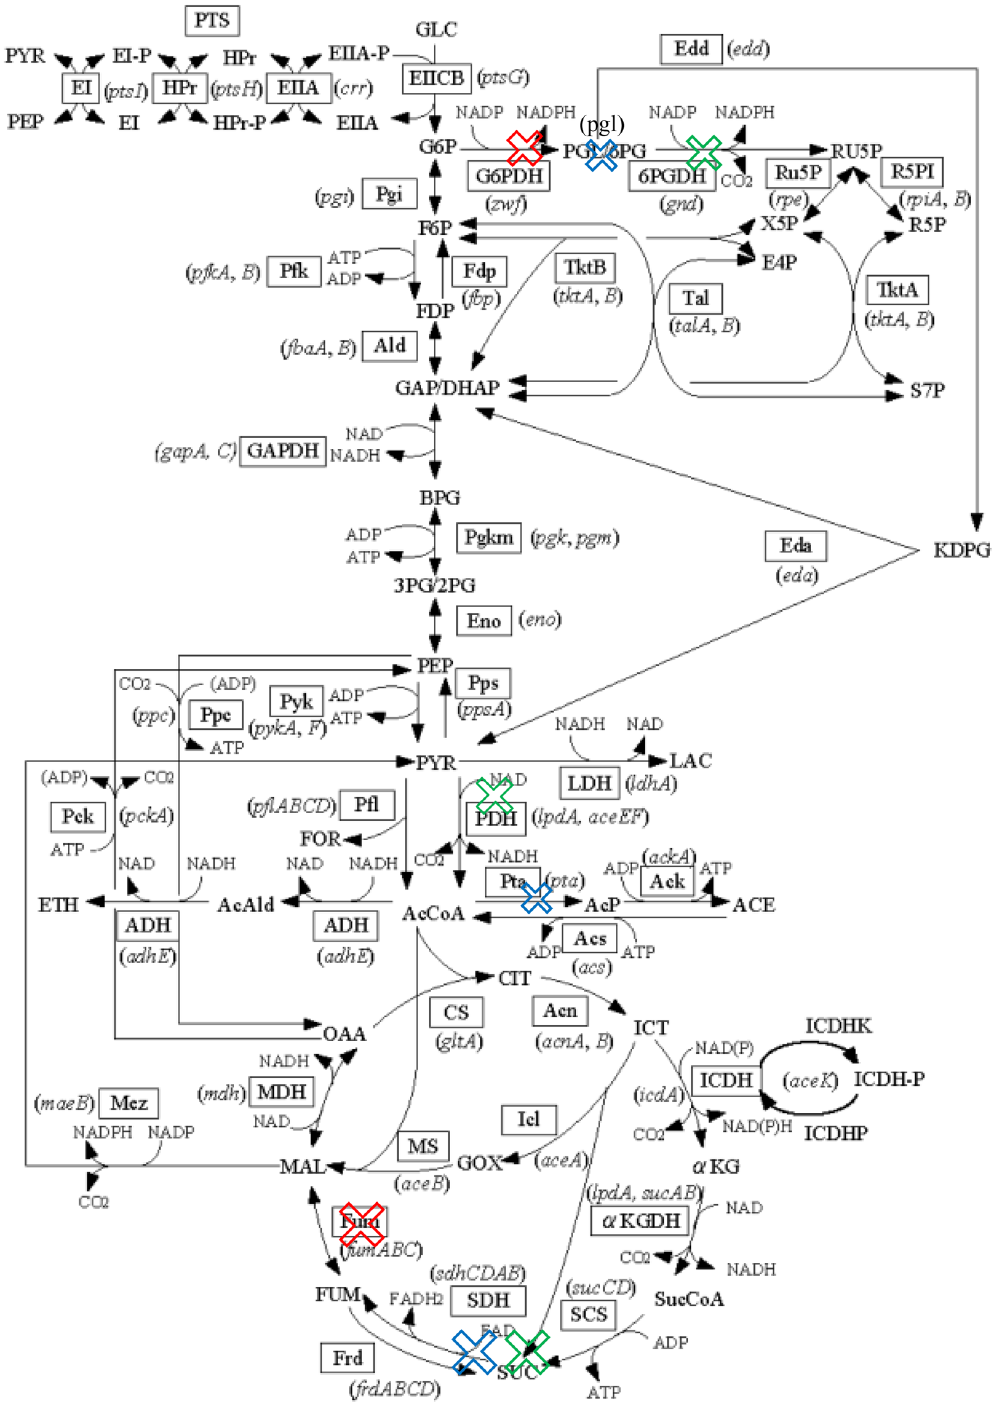
Figure 4: Metabolic pathway of Escherichia coli for succinate. The crosses with red, blue, and green color respectively denote mutant A, B, and C,